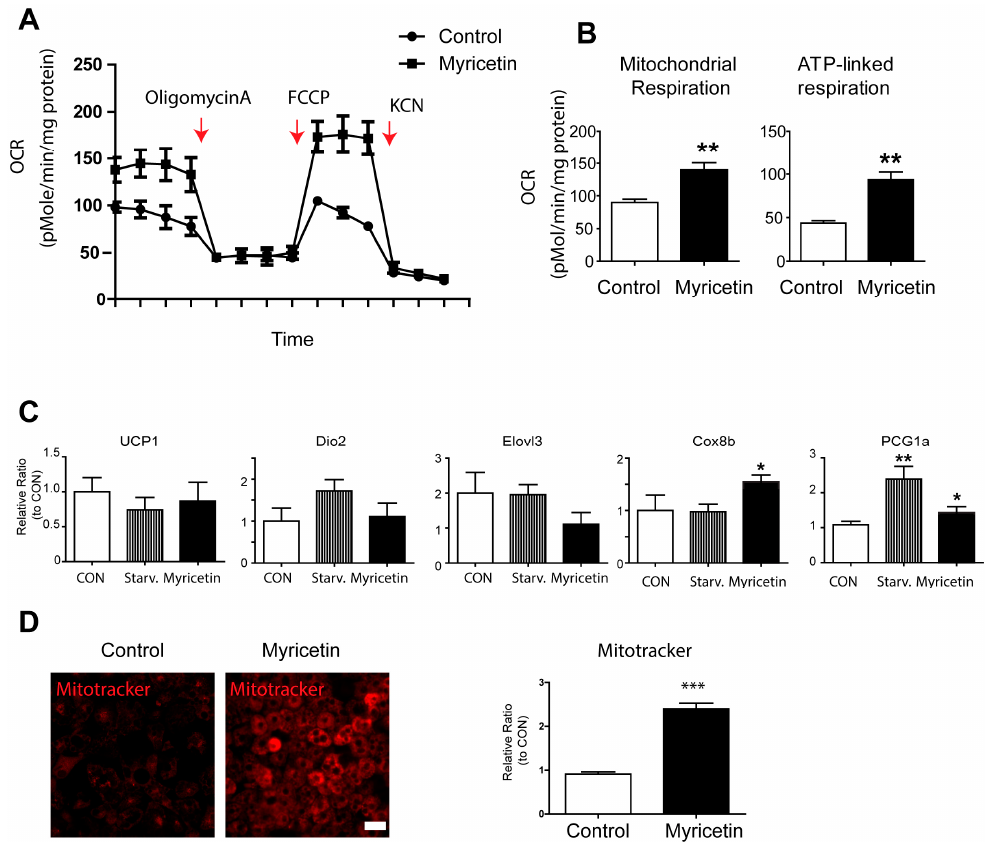
Figure 3. In vitro effects of myricetin on mitochondrial respiration and brown adipocyte specific marker expression in adipocytes. ( A ) Analysis of oxygen consumption rate (OCR) of adipocytes differentiated from C3H10T1/2 cells treated with vehicle controls (CON), and myricetin (10 µ M) for 24 h with a series of treatments of indicated drugs (Oligomycin, Carbonyl cyanide-4-(trifluoromethoxy)phenylhydrazone (FCCP), and potassium cyanide (KCN)). Arrows indicate the time of the treatments. ( B ) Comparisons of basal mitochondrial respiration and ATP-linked respiration between cells treated with myricetin and vehicle controls. (two-tailed unpaired t -test). ( C ) Quantitative PCR analysis of the genes involved in mitochondrial respiration and brown adipocyte specific markers in adipocytes differentiated from C3H10T1/2 and treated with myricetin (10 µ M) for 24 h ( D ) MitoTracker staining of adipocytes differentiated from C3H10T1/2 cells treated with myricetin (10 µ M) for 24 h and vehicle controls ( n = 3, means ± SEM, * p < 0.05, ** p < 0.01, *** p < 0.001). Size bar = 20 µ m 3.3. Myricetin Increased Sirt1, Sirt3, and Sirt5 Expression in Adipocytes The sirtuin family has been reported as a regulator of mitochondrial function and mitochondrial biogenesis. As myricetin affects mitochondrial content and mitochondrial OCR in adipocytes, we examined the expression of sirtuin proteins in adipocytes as potential indicators of the downstream mechanisms of the effects of myricetin. As shown in Figure 4, western blotting analysis indicated that Sirt6 and Sirt7 expressions were not affected; however, slight upregulation of Sirt1 was observed. Furthermore, the expression levels of mitochondrial sirtuins, Sirt3 and Sirt5, were significantly upregulated by myricetin treatment (Figure 4A,B,C). These data suggested that the induction of mitochondrial sirtuins by myricetin was related to the increase in mitochondrial respiration.